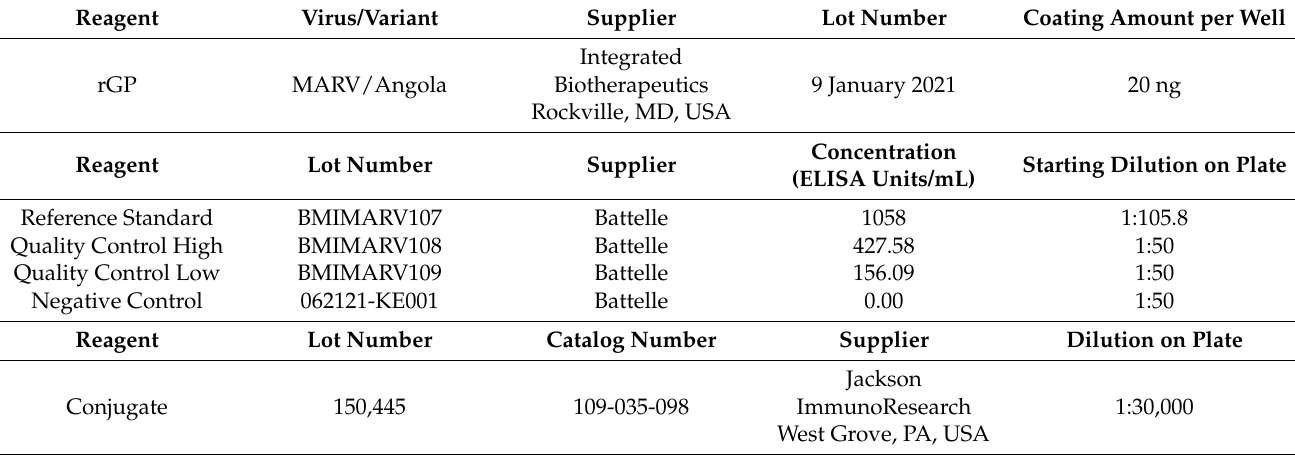
Table 2. Anti-MARV GP IgG ELISA Critical